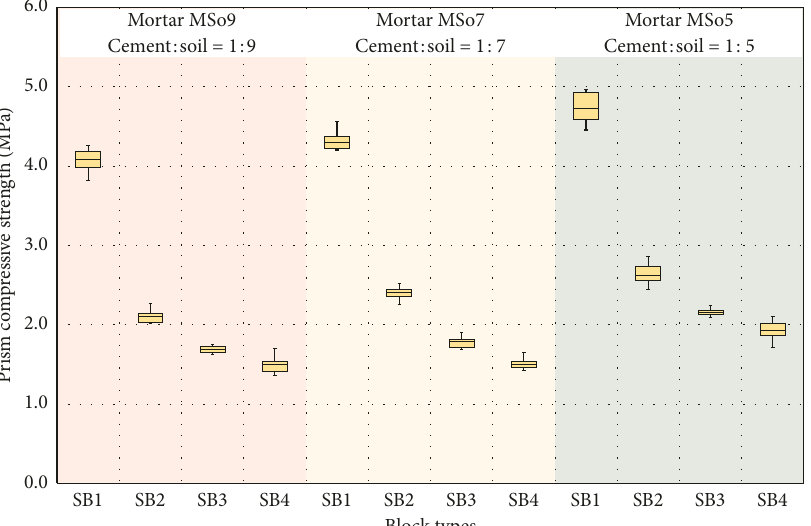
Figure 3: Compressive strength variation of masonry prisms with different blocks and cement-soil mortar